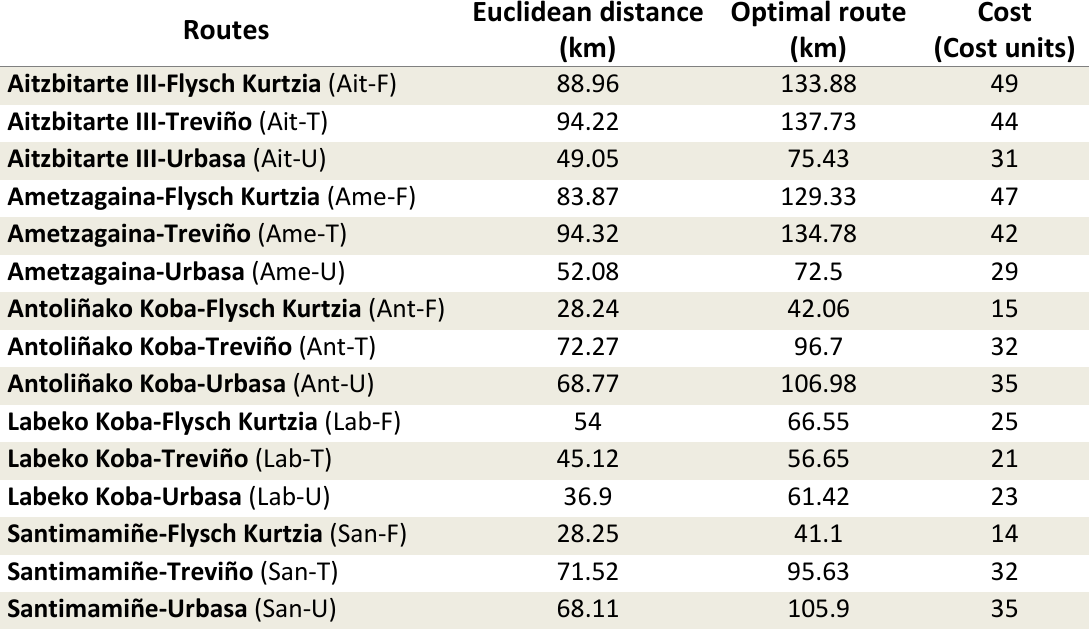
Table 2. Value of each possible site-outcrop route according to the three measurement methods proposed